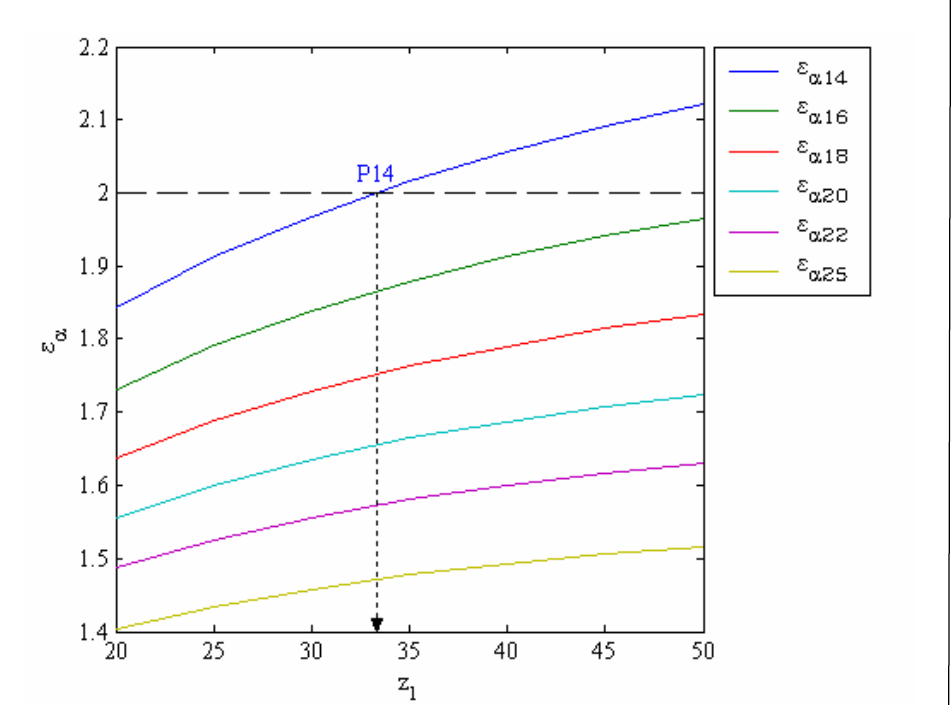
Figure 7 – Transverse contact ratio for x 1 =0.5 , x 2 =0.5 and z 2